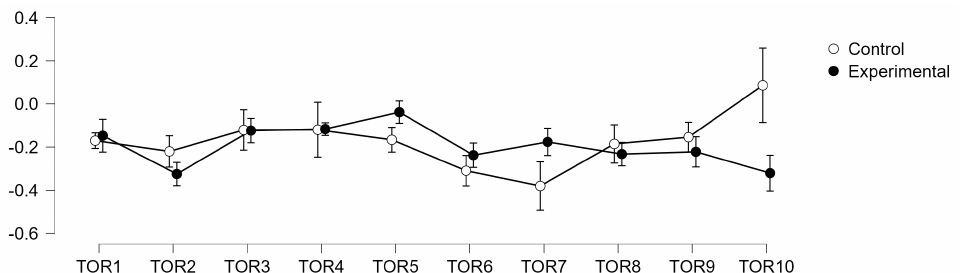
Figure 5. The mean standardized coefficient of variance of the vehicle jerk for both groups and each